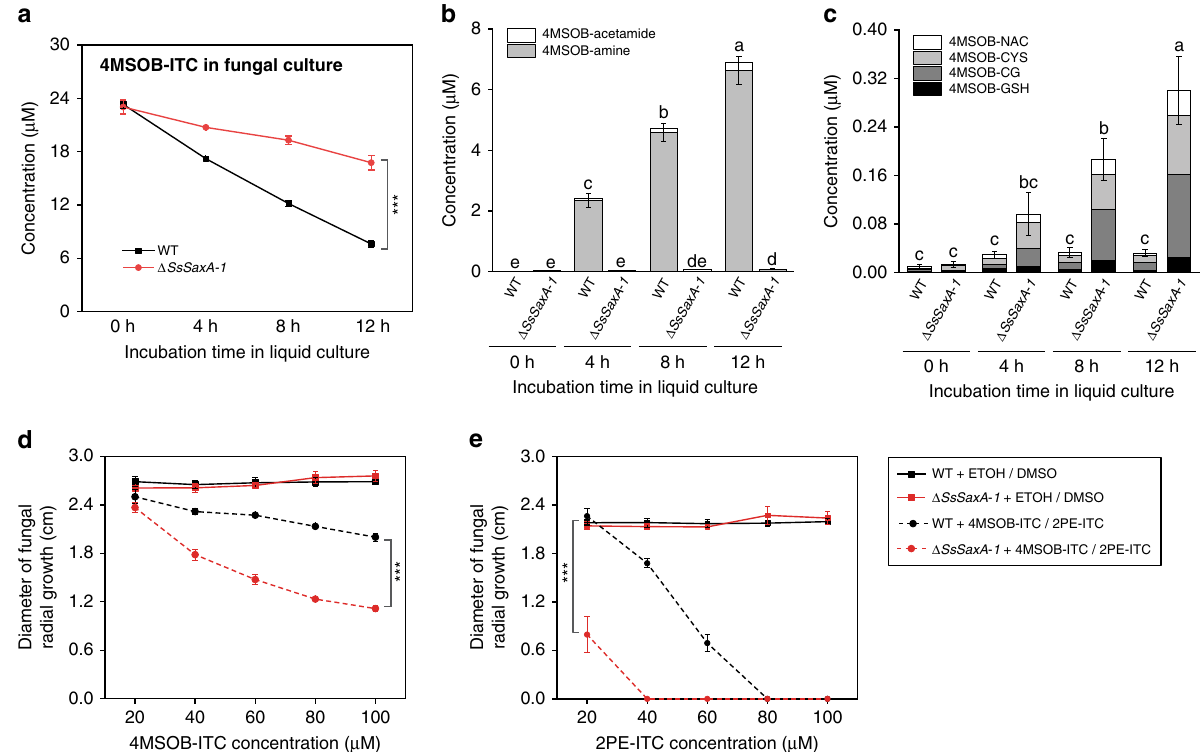
Fig. 6 SsSaxA deletion reduces ITC degradation ef fi ciency and growth in ITC-containing medium. a Quanti fi cation of 4MSOB-ITC in both wild-type (WT) and Δ SsSaxA -1 cultures over a time course. Twenty- fi ve micromolar 4MSOB-ITC was used for each culture. Data represent mean ± SEM ( n = 3 independent fungal cultures) and were analyzed by one-way ANCOVA (*** p < 0.001 for WT/ Δ SsSaxA-1 ). Quanti fi cation of the degradation products b 4MSOB-amine and 4MSOB-acetamide and c 4MSOB-ITC conjugates in WT and Δ SsSaxA-1 cultures supplemented with 4MSOB-ITC. For degradation products, data were analyzed by a Kruskal – Wallis rank sum test ( p < 0.01) followed by a Games – Howell post-hoc test; for conjugates, data were analyzed by one-way ANOVA ( p < 0.001) followed by Tukey ’ s post-hoc test. Different letters above the bars indicate signi fi cant differences at p < 0.05. Deletion of SsSaxA in S. sclerotiorum resulted in reduced growth in culture medium in the presence of both d 4MSOB-ITC and e 2PE-ITC. Diameter of fungal radial growth was measured 24 h after co-incubation with these compounds. Data represent mean ± SEM ( n = 3 independent fungal culture; growth assays of WT and Δ SsSaxA mutants with ITCs were repeated once) and were analyzed by one-way ANCOVA (4MSOB-ITC or 2PE-ITC treatment, *** p < 0.001 for WT/ Δ SsSaxA-1 ). 4MSOB-ITC, 4-methylsul fi nylbutyl isothiocyanate; 4MSOB-GSH, 4MSOB-ITC glutathione conjugate; 4MSOB-CG, 4MSOB-ITC cysteinylglycine conjugate; 4MSOB-CYS, 4MSOB-ITC cysteine conjugate; 4MSOB-NAC, 4MSOB-ITC N -acetylcysteine conjugate; 4MSOB-amine, 4- methylsul fi nylbutylamine; 4MSOB-acetamide, 4-methylsul fi nylbutylacetamide; 2PE-ITC, 2-phenylethyl isothiocyanate. Source data are provided as a Source data fi